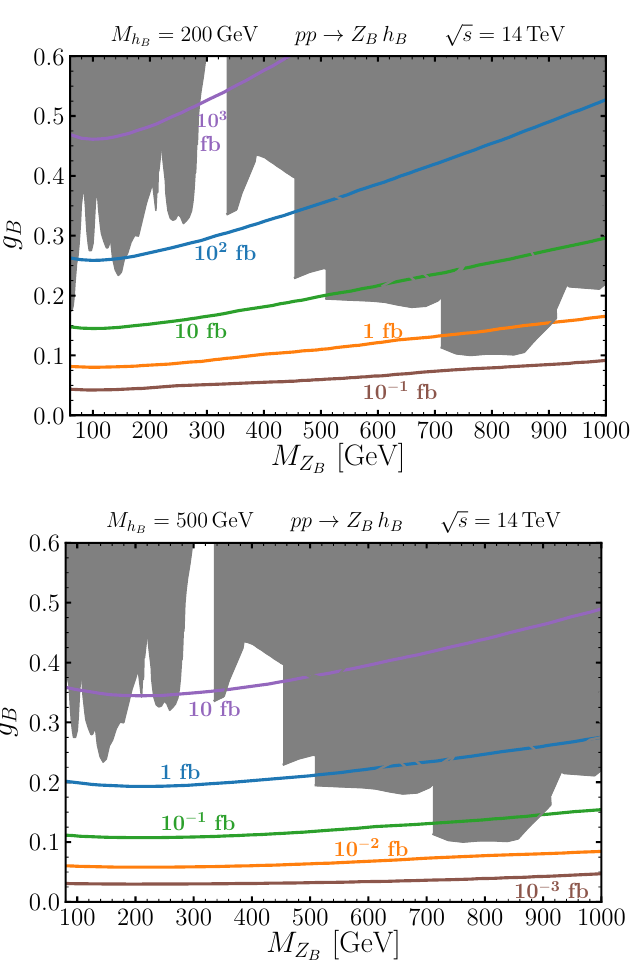
Figure 8 . Contour lines for the production cross-sections for the process pp → Z ∗ the LHC with center-of-mass energy of 14 TeV. These results have a very weak dependence on the mixing angle for sin θ 10 − 2 . In the upper (lower) panel the scalar mixing angle is fixed to B < sin θ = 10 − 3 (with identical results for sin θ = 10 − 2 ). The region shaded in gray is excluded by B B direct searches for the Z at the B